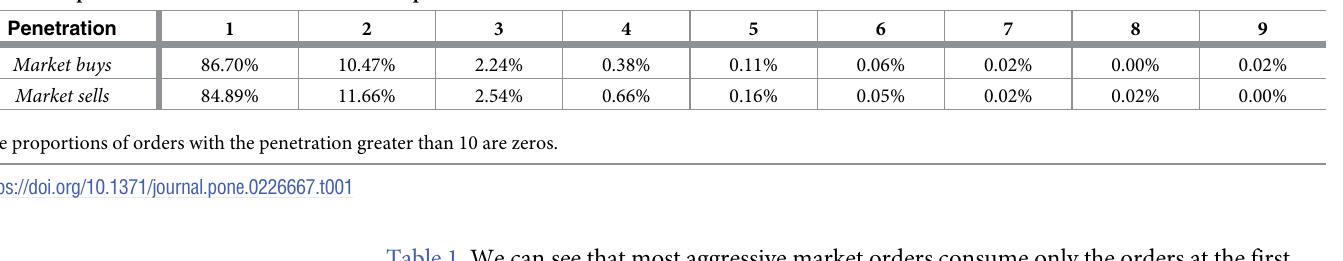
Table 1. Proportions of market orders with different penetrations. Penetration